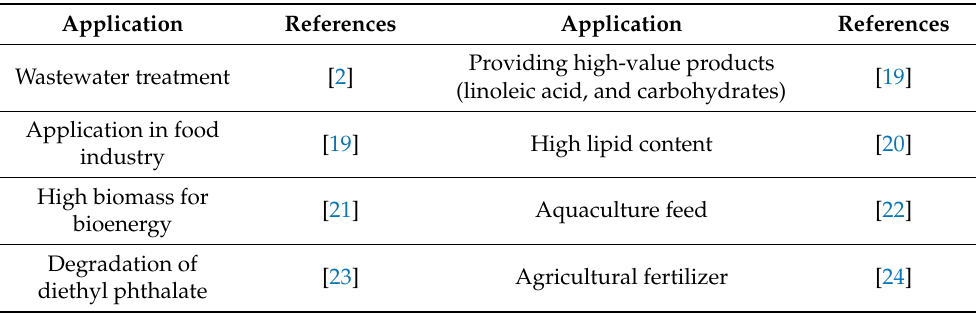
Table 1. Advantages and uses of Chaetoceros muelleri